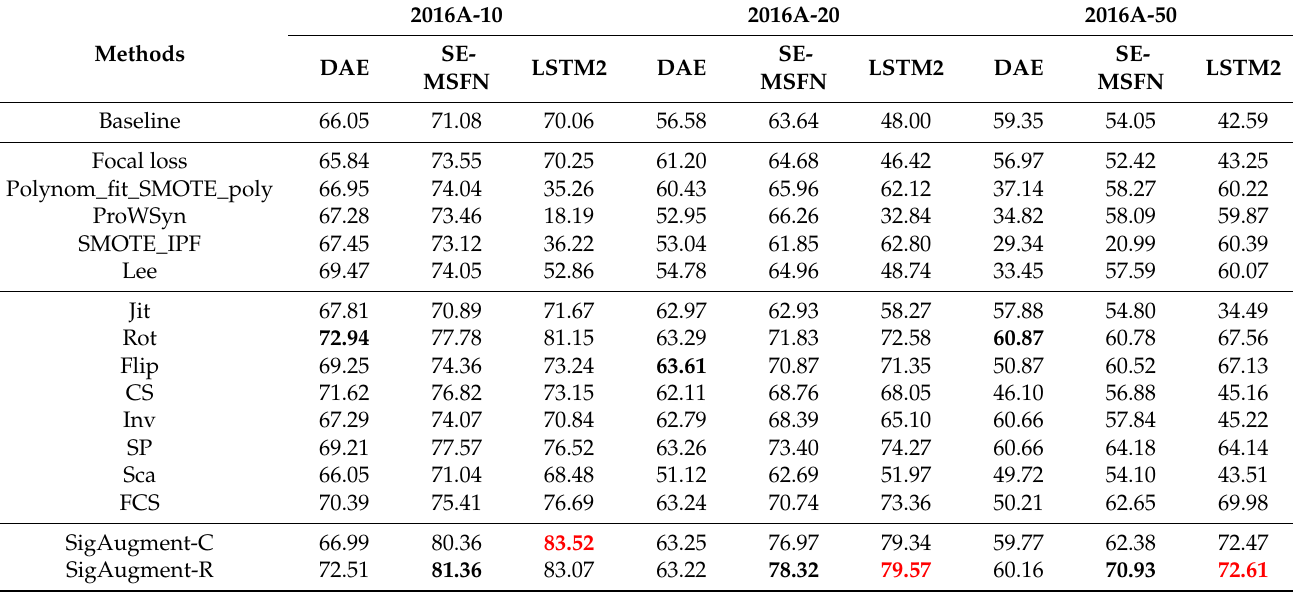
Table 5. On three class-imbalanced datasets, 2016A-10, 2016A-20, and 2016A-50, the proposed methods were compared to existing representative class rebalancing methods and individual trans- formations. The accuracy (%) is calculated as the mean of three experiments. The best-performing individual model results are shown in bold, while the best-performing dataset results are shown in bold and